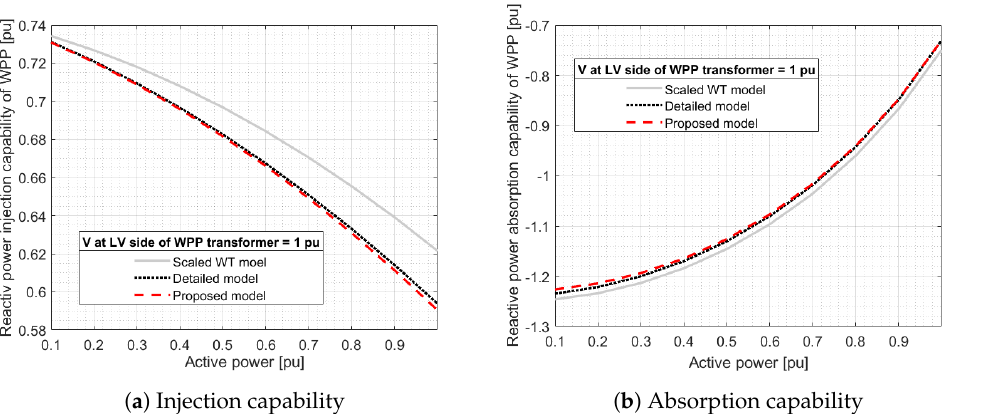
Figure 9. Comparison of WPP reactive power capability using scaled WT model, detailed model and proposed